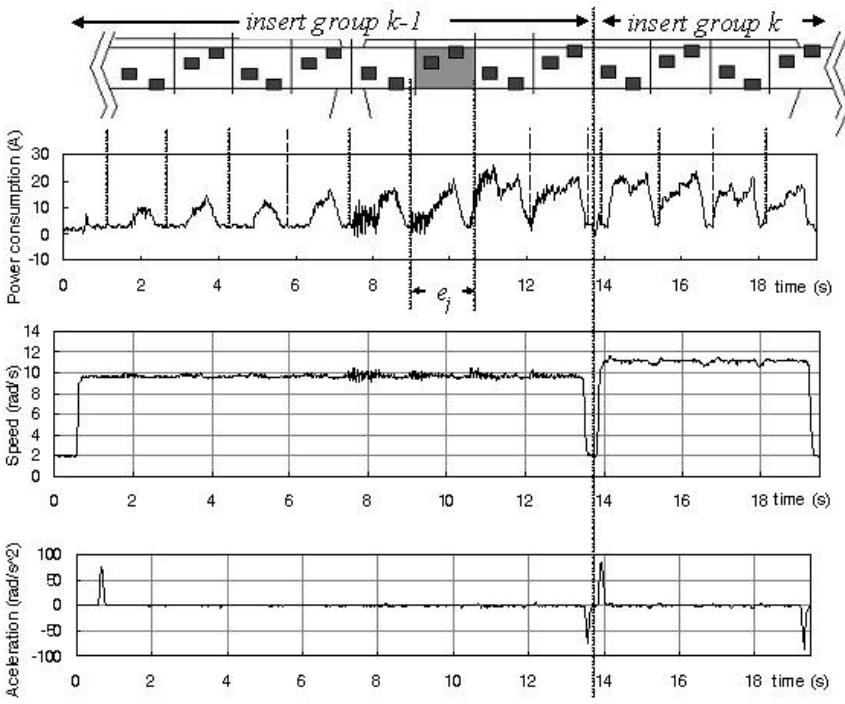
Figure 4. Signal segmentation based on the tool’s